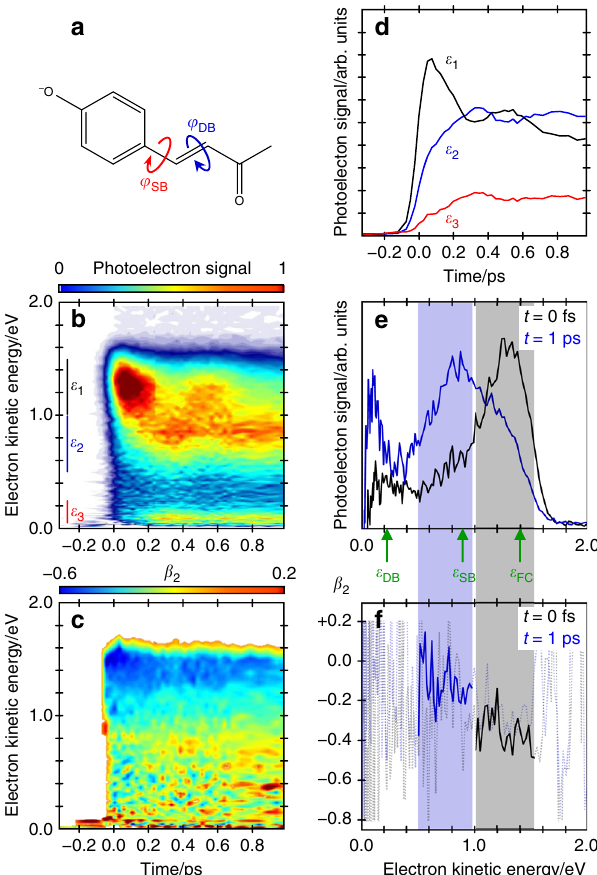
Fig. 1 Excited state dynamics of p CK − . a Structure of p CK − with arrows indicating single ( φ SB ) and double ( φ DB ) bond rotation. b Time-resolved photoelectron spectra plotted as a normalised false-colour map with a t < 0 spectrum subtracted and where white indicates signal <0. c time- resolved β 2 false-colour map, where values are omitted whenever the signal level is <0.1 in b . d Integrated photoelectron signal over spectral windows ε ε ε 1 , 2 , and 3 indicated in b . e Photoelectron spectra at representative of spectral windows ε 1 and ε 2 in b , respectively. f β 2 corresponding to spectra in e as indicated by shaded regions. Vertical arrows in d show the maximum kinetic energy expected for detachment from the Franck-Condon, single-bond, and double bond rotated minima, ε ε ε FC , SB , and DB ,